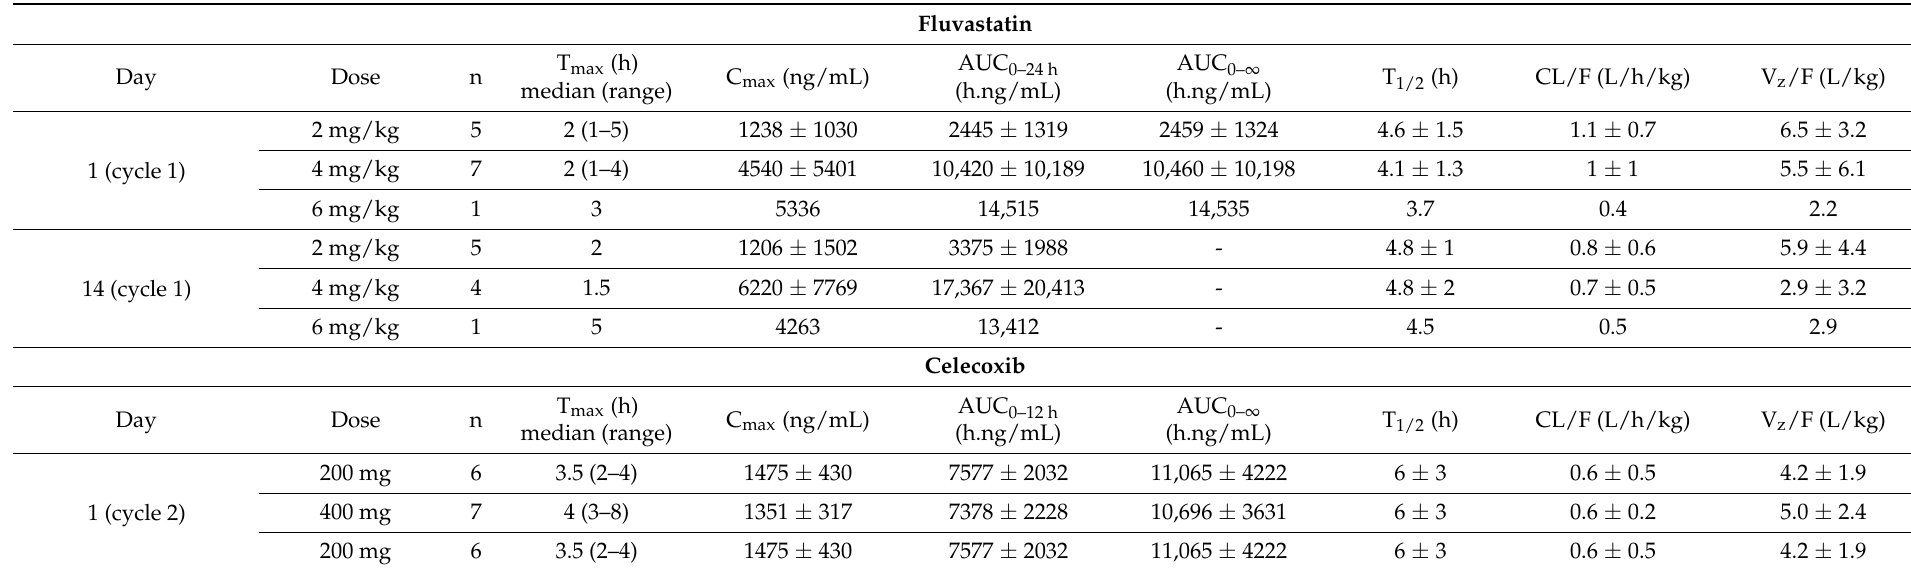
Table 5. Summary of the fluvastatin and celecoxib pharmacokinetic parameters (mean ± standard deviation unless otherwise